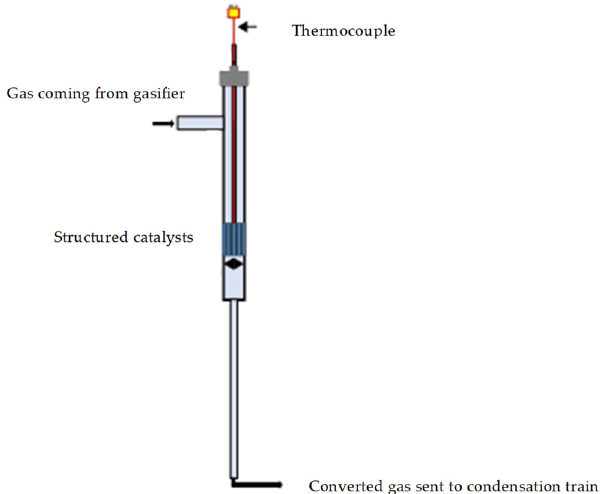
Figure 2. Schematic representation of the quartz reactor containing the structured